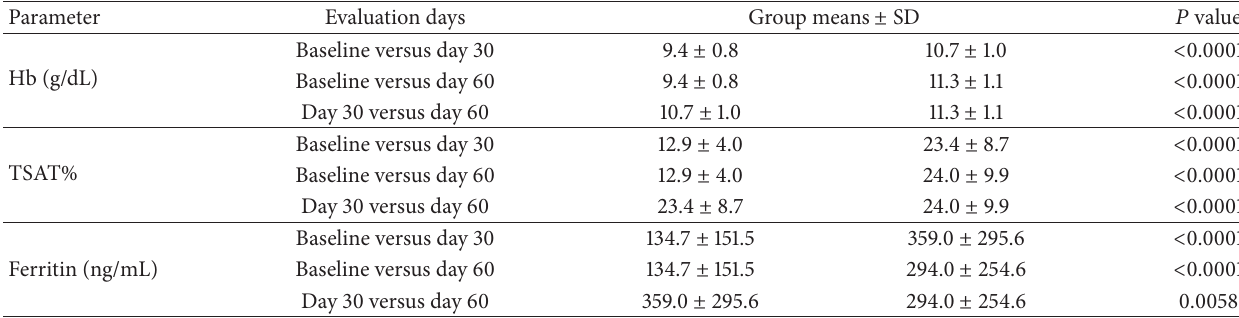
Table 2: Parameter comparison at three evaluation points in iron dextran